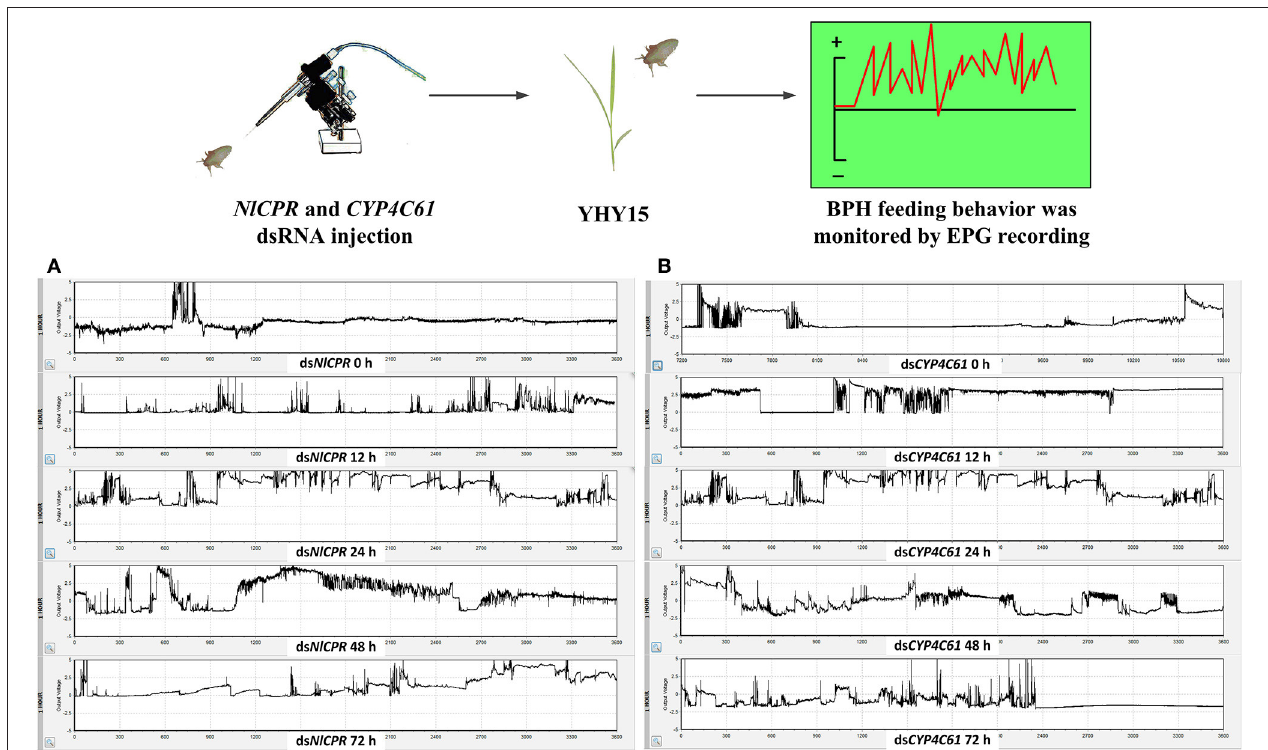
FIGURE 6 | Overall typical EPG waveforms for NlCPR and CYP4C61 dsRNA - treated BPH on YHY15 plants. (A) EPG waveforms of NlCPR dsRNA-treated BPH for 0, 12, 24, 48, and 72h. (B) EPG waveforms of CYP4C61 dsRNA-treated BPH for 0h, 12, 24, 48, and